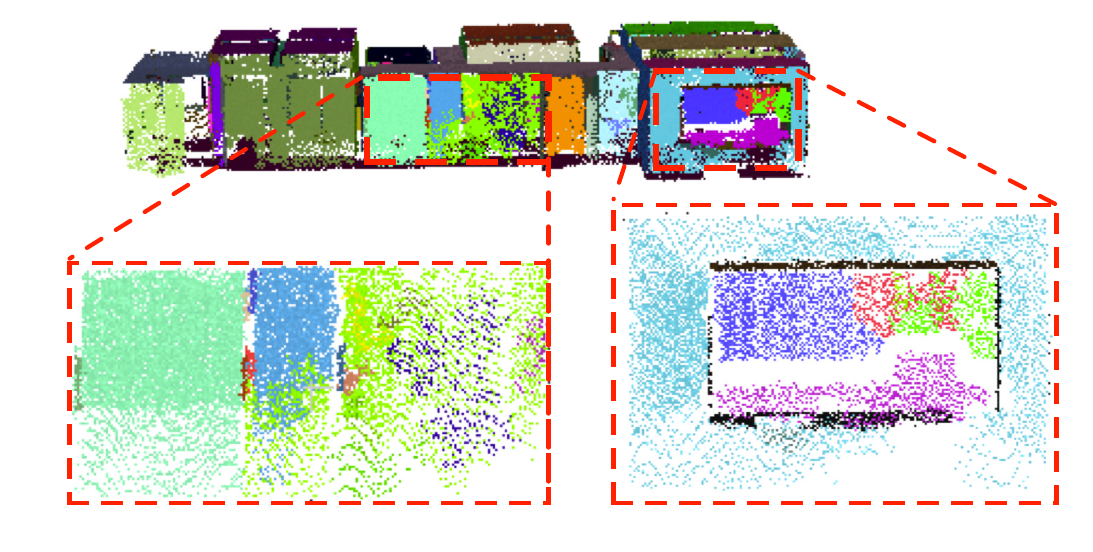
Figure 3. The result of region-growing: enlarged drawings show that the co-planar walls have been separated into several